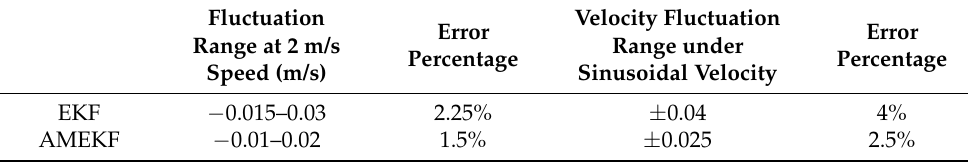
Table 2. Velocity fluctuation